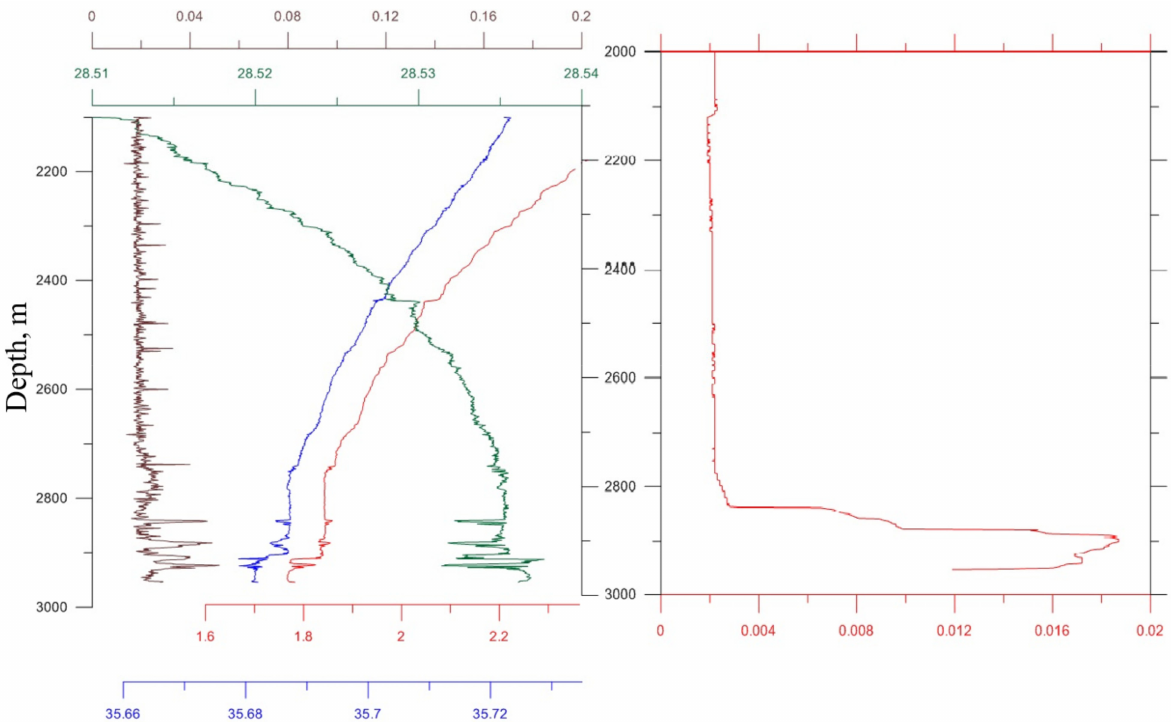
Figure 3. Results of CTD sounding at the Irina 1 crater, Logachev field. Left: brown—turbidity, FTU; blue—salinity, ‰; red—temperature, ◦ C; green—density, kg/m 3 ); right graph: methane concentration, µ